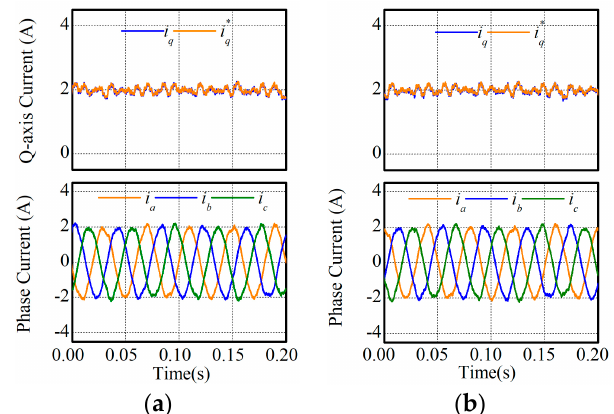
Figure 13. Steady-state performances with inaccurate mover inductance: ( a ) MPCC-I and ( b ) MPCC-II. Table 5. Performance comparison with inaccurate mover inductance.